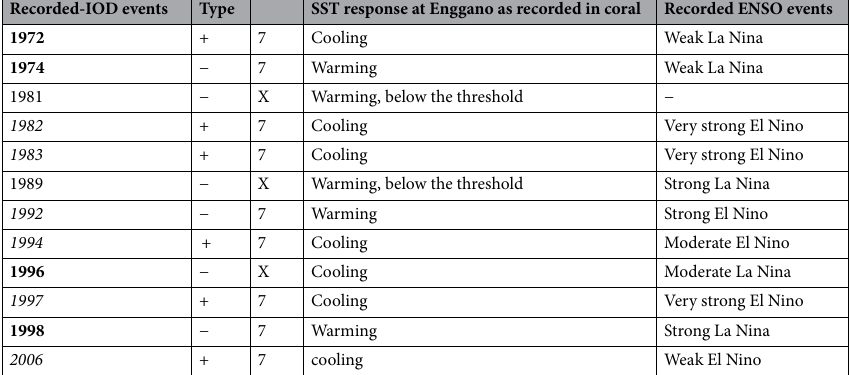
Coral indicates cooling